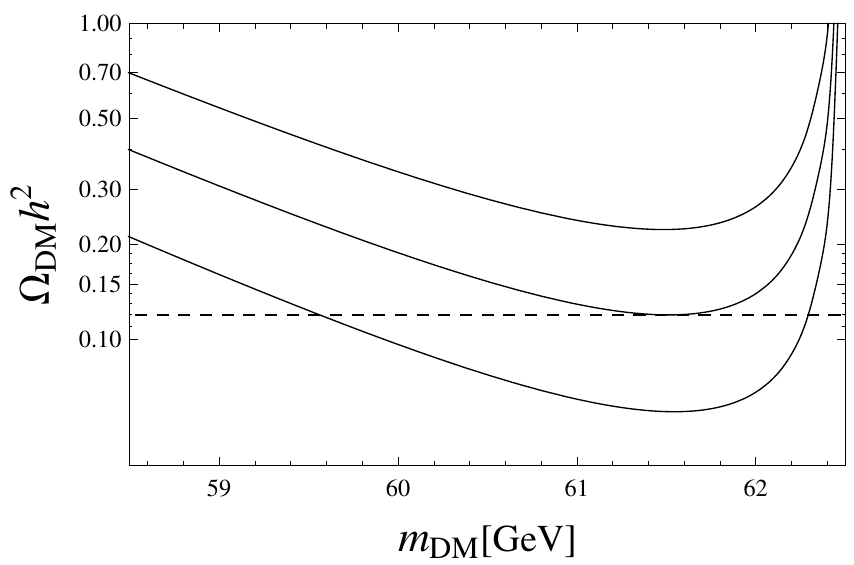
Figure 1 . The DM relic density as a function of the DM mass for various y DM values (solid lines), along with the observed DM density Ω DM h 2 = 0 . 1198 (horizontal dashed line) The three solid lines form top to bottom correspond to y DM = 0 . 005, 0 . 00692, and 0 . 01, respectively.